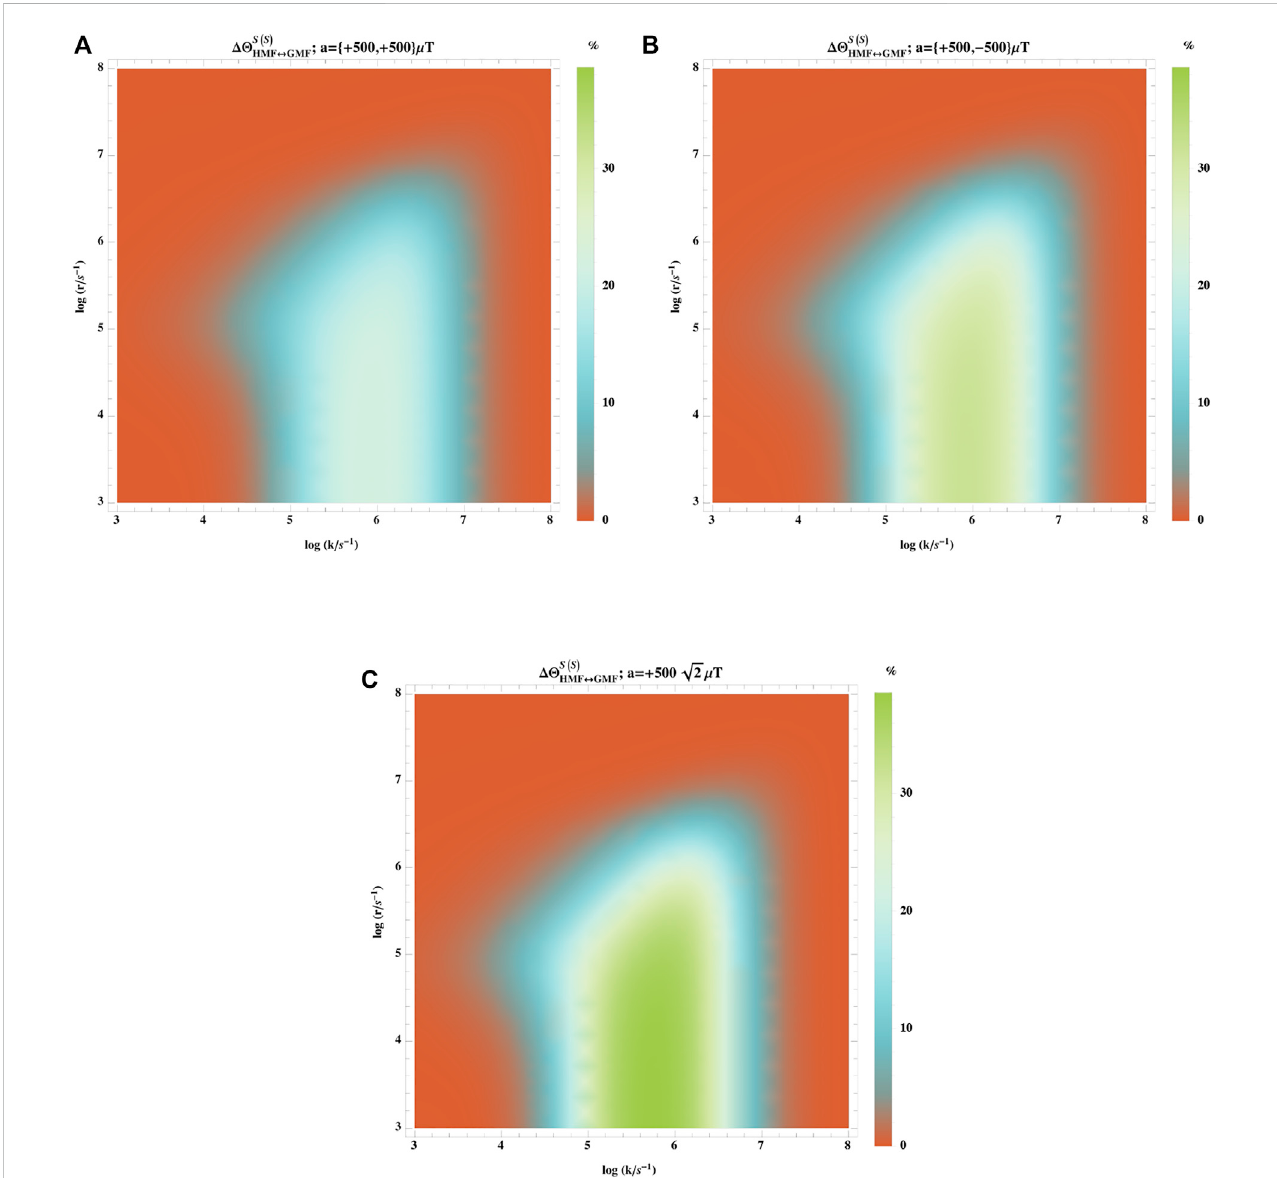
FIGURE 5 Comparing different signs for the hyper fi ne couplings in the case of multiple nuclei. Dependence of ΔΘ S ( S ) HMF ↔ GMF on k , r , and signs of the hyper fi ne couplingconstants.Thehypomagnetic fi eldeffectisbasedonthesingletyieldratioof1 μ T(HMF)over μ T(GMF)withinitialsingletstates. Inthismodel,oneof the radicals has no hyper fi ne interaction and the other one is coupled to two nuclei with these isotropic hyper fi ne coupling constants: (A) a iso = { + 500, + (cid:16)(cid:16) √ μ T. The signs of the hyper fi ne couplings have a negligible impact on the fractional yield for the 500} μ T, (B) a iso = { + 500, − 500} μ T, (C) a eiso (cid:1) 500 2 hypomagnetic fi eld effects. The effective coupling constant has a stronger effect than the other coupling